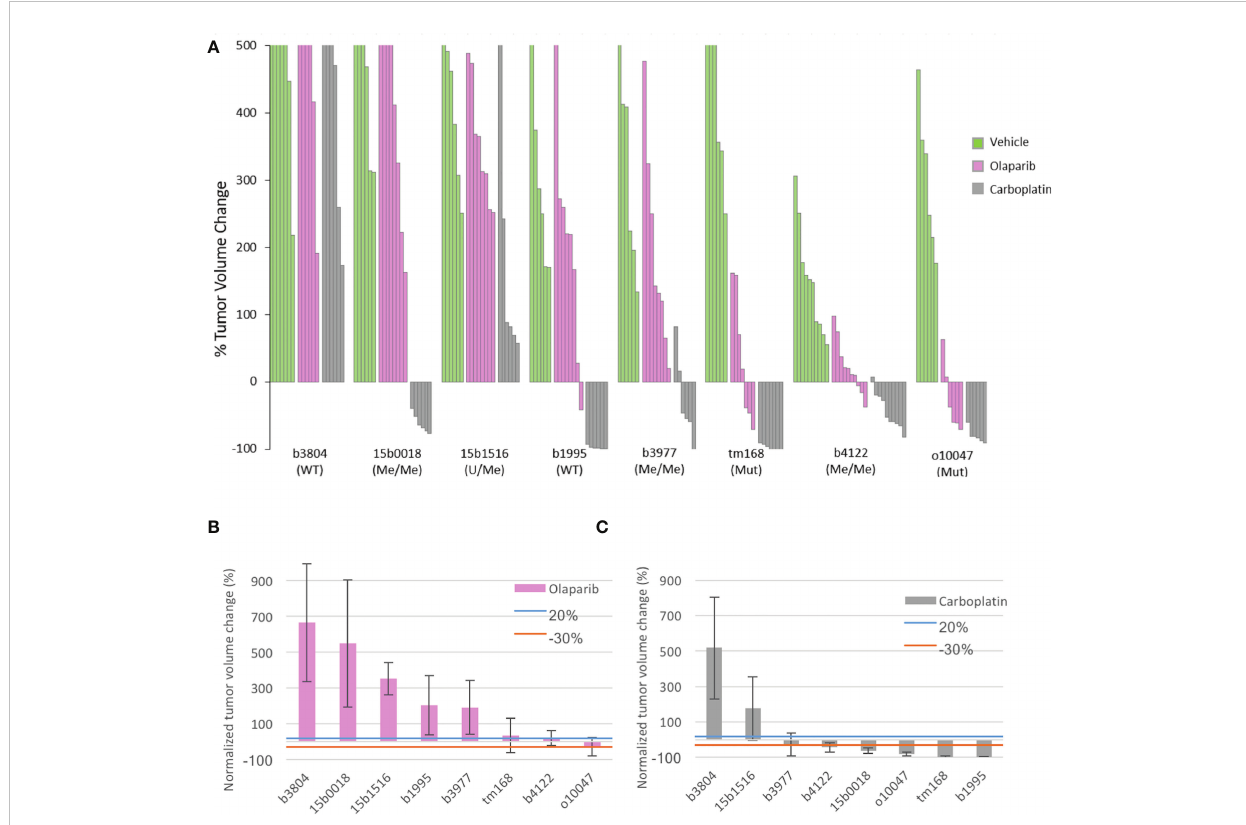
FIGURE 1 Tumor volume change of the 8 PDX models under olaparib and Carboplatin treatment and principal characteristics related to HR of the PDX models (A) Waterfall plot of tumor volume changes in the 3 experimental arms were computed at the end of treatment for individual tumors as the percentage of the starting volume (green vehicle; pink olaparib, grey Carboplatin) (B) mean tumor volume change in each PDX model treated with olaparib. (C) mean tumor volume change in each PDX model treated with Carboplatin. Blue an orange lines indicate the +20% and − 30% thresholds for tumor response de fi ned by the RECIST criteria; > 20% progressive (PD). < 20%- > -30% stable disease (SD). < 30% responsive